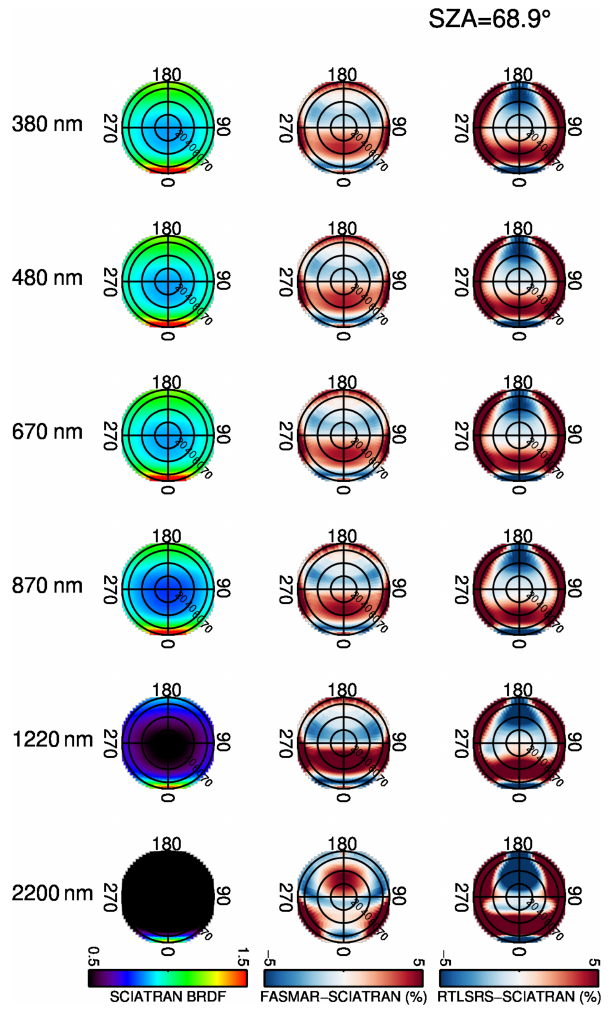
Figure 5. BRDF of the snow layer calculated using SCIATRAN and the difference between the results from the FASMAR/RTLSRS models and SCIATRAN simulations for wavelengths of 380, 480, 670, 870, 1220 and 2200nm and a solar zenith angle of 68.9 ◦ .